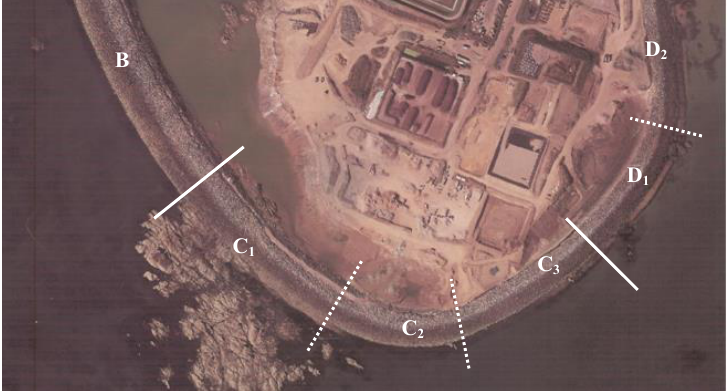
Figure 10. Locations of sub-sections C1 – C3, D1 and D2.